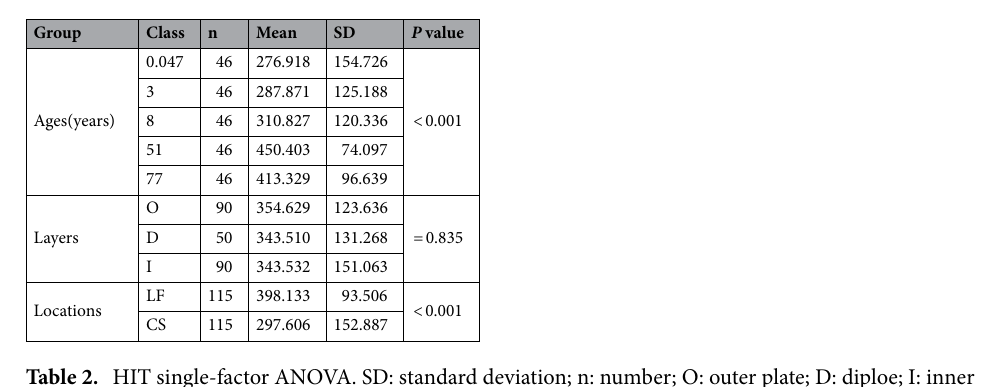
Table 2. HIT single-factor ANOVA. SD: standard deviation; n: number; O: outer plate; D: diploe; I: inner plate; LF: left frontal; CS: coronal suture (Tables 3, 6 and 7 are the